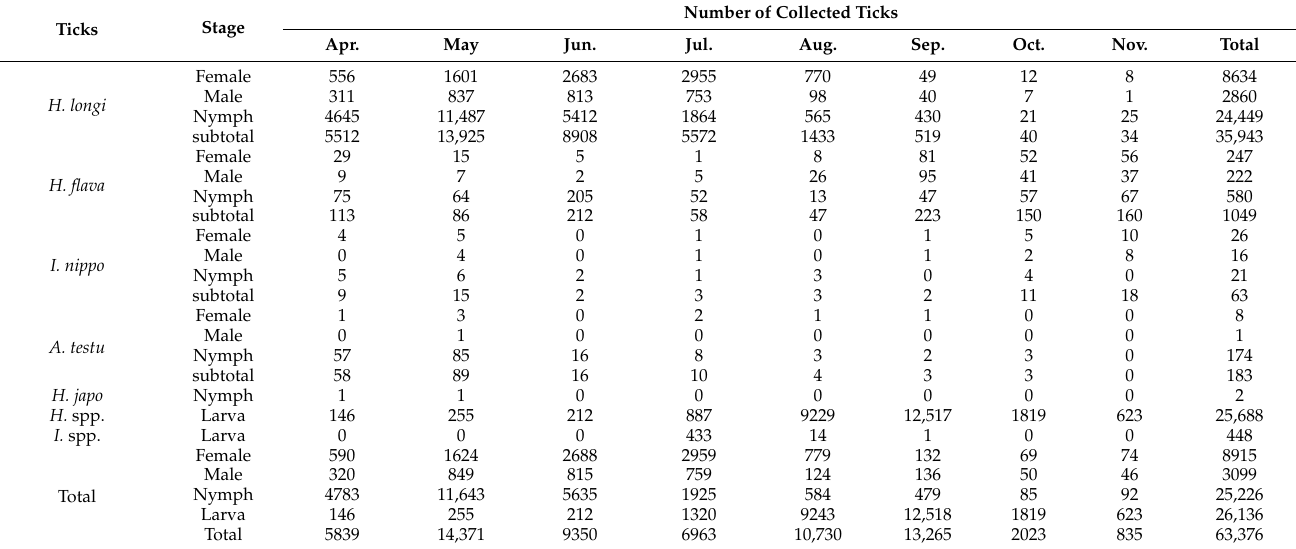
Table 2. Temporal distribution of ticks and SFTSV infection in Korea in 2020.